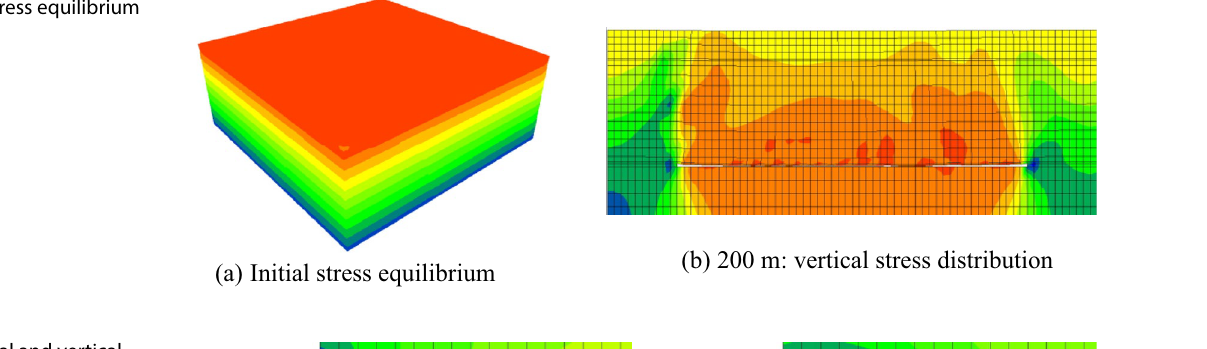
Fig. 8 Horizontal and vertical displacements at an 8.8-m mining height